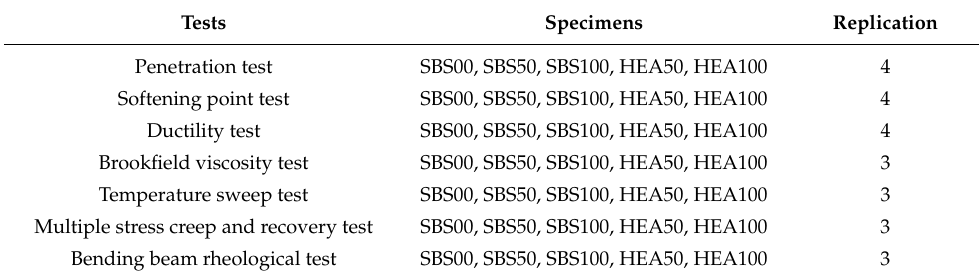
Table 6. Samples